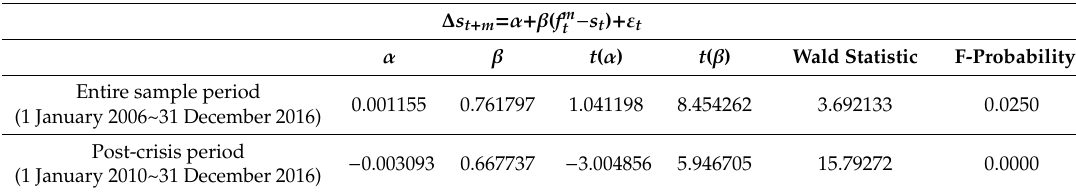
Table 9. Fama’s regression results for the